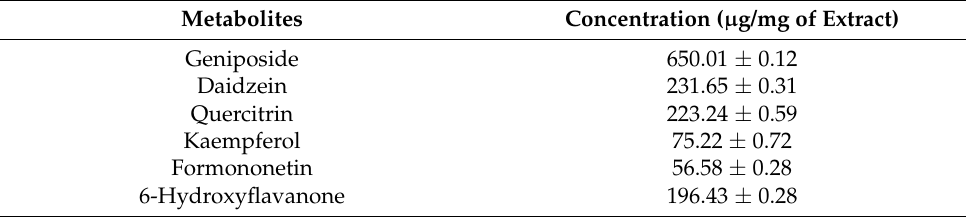
Table 3. Concentration of metabolites in M. calabura FD leaves extracted with 50%